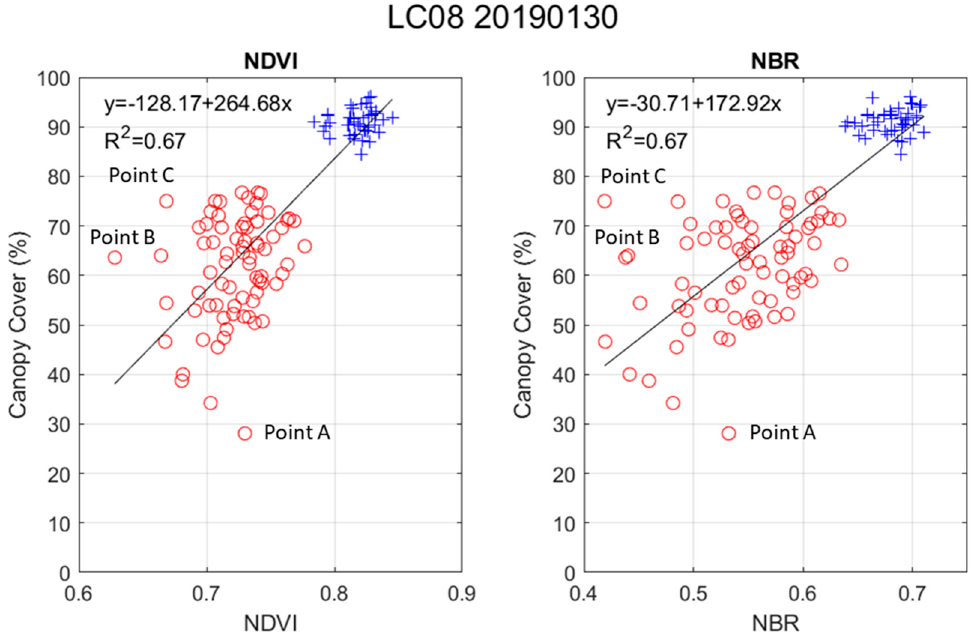
Figure 7. Scatter plots between the 2019 L8 OLI-derived NDVI / NBR and in-situ canopy cover. The canopy cover data were obtained on 19 and 25–26 February 2019, and the L8 OLI imagery used to derive NDVI and NBR was acquired on 30 January 2019.